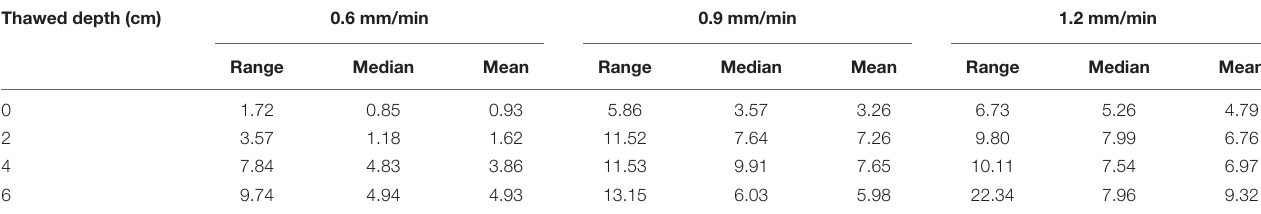
TABLE 2 | The statistics of soil loss rate for different thawed depth under changing rainfall intensity. Thawed depth (cm)